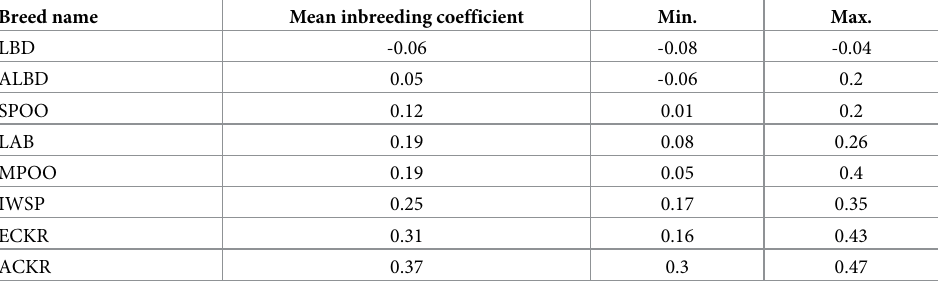
Table 1. Mean inbreeding coefficient values for ALBD and LBD vs. established